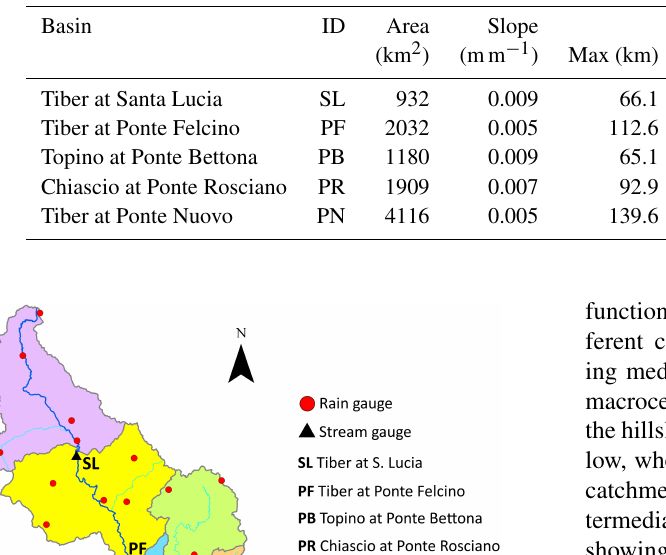
Table 1. Main geomorphic characteristics of the inter-basin drainage areas within the Upper Tiber river basin (CV: coefficient of variation).